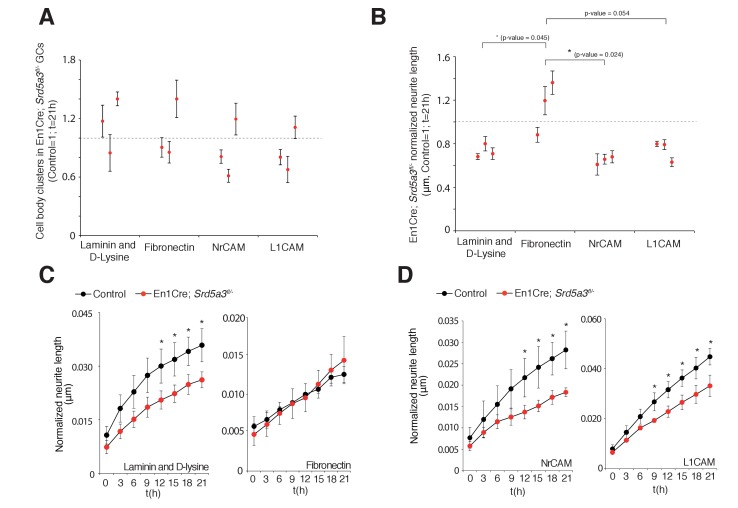
Changes in granule cell (GC) number and neurite length under different coating conditions.(A) GC body cluster number after 21 hr using different coatings and normalized to control littermates. (B) Neurite length in mutant GCs normalized to GC body cluster number after 21 hr. Each dot per coating represents results from a single mutant mouse. All GC cultures were performed in technical triplicates (n = 3 for each genotype). Student t-test was used for statistics. (C) Normalized neurite length of GCs under different coating conditions, laminin and polyD-lysine or fibronectin, and (D) L1CAM and NrCAM coating. *p<0.05. Results are presented as mean ± s.d.